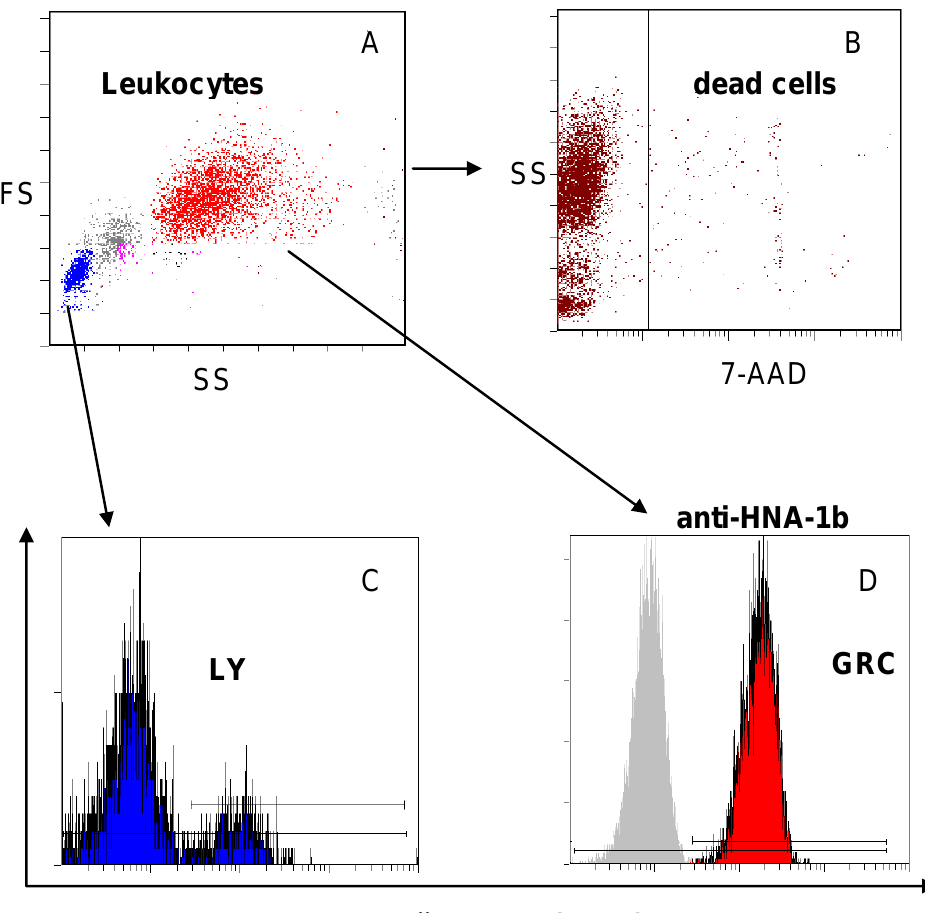
FIGURE 2. An example of flow cytometric analysis of a serum containing granulocyte- specific IgG anti–HNA-1b. Granulocytes and lymphocytes were separately investigated on cell-bound fluorescence in each histogram composed by the first fluorescence channel (FITC) and count. This antibody bound only on granulocytes due to the expression of HNA- 1b on granulocytes (GRC) and absence of this antigen on lymphocytes (LY). This anti– HNA-1b does not show cytotoxic effect (7-AAD negative). The shadow indicates negative